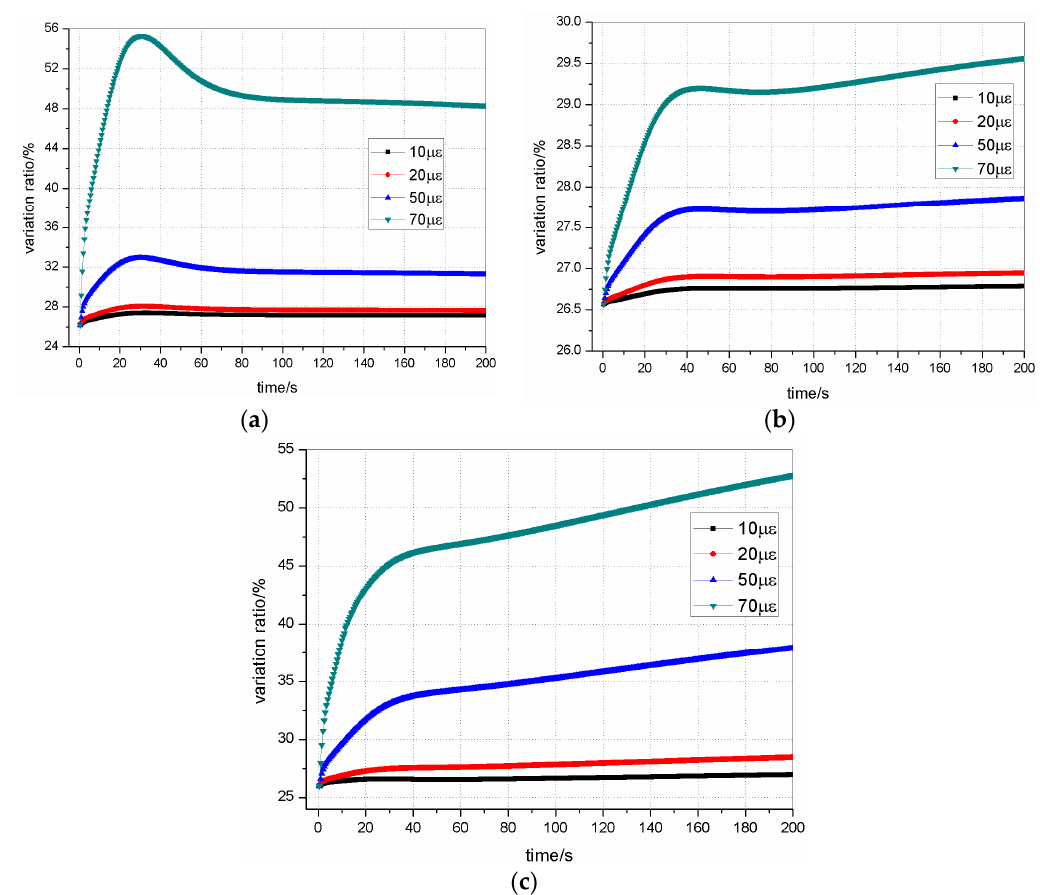
Figure 13. The von Mises stress variation ratio at three locations: ( a ) stress variation ratio at location 1; ( b ) stress variation ratio at location 2; and ( c ) stress variation ratio at location 3.